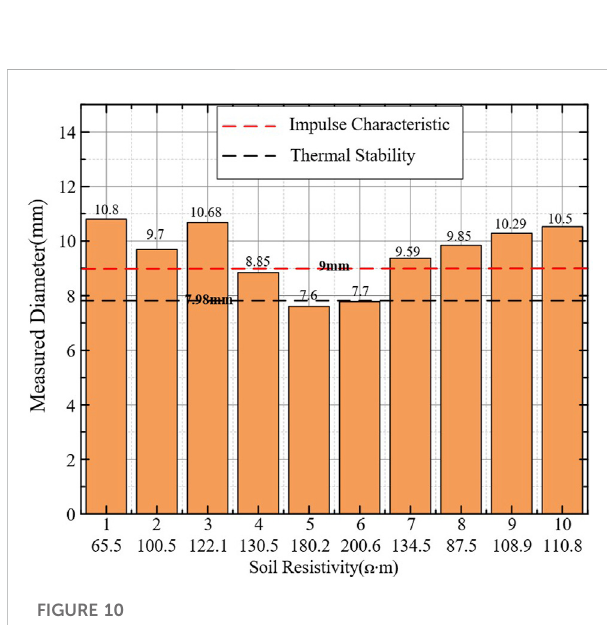
FIGURE 9 Grounding impedance value.